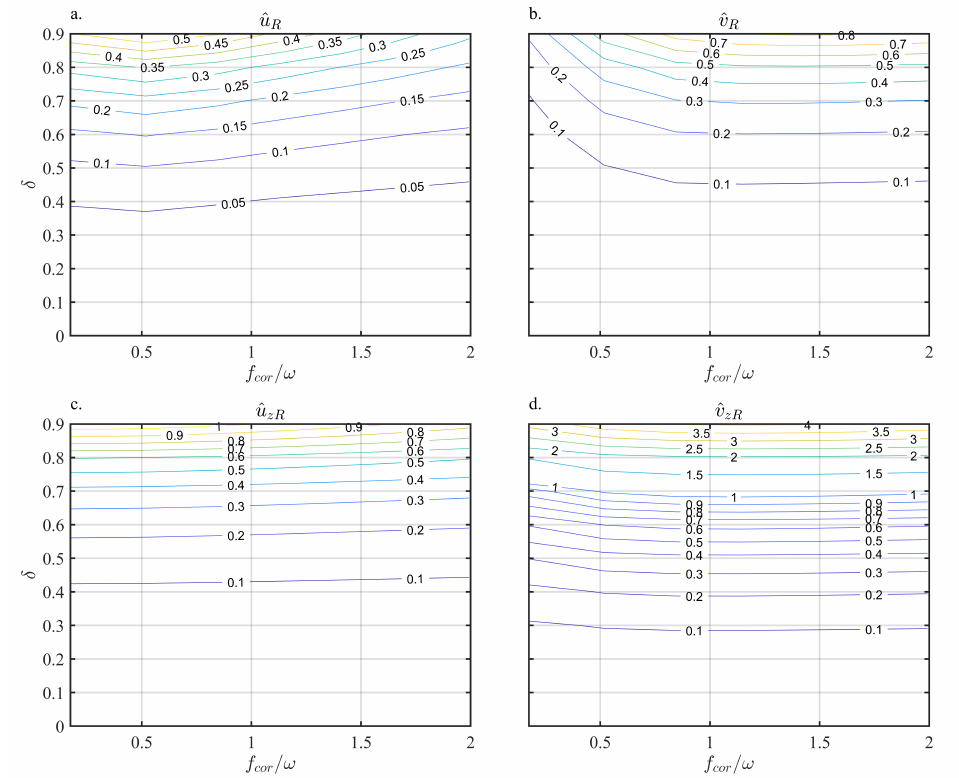
Figure 10. Parameter dependence for the normalized rectification values (25) for: ( a ). zonal velocity ˆ u R , ( b ). meridional velocity ˆ v R , ( c ). zonal shear ˆ u zR , and ( d ). meridional shear ˆ v zR